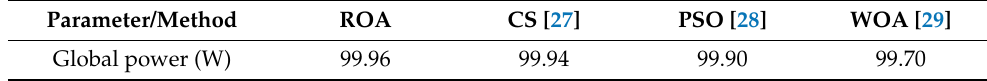
Table 8. Results comparison with previous